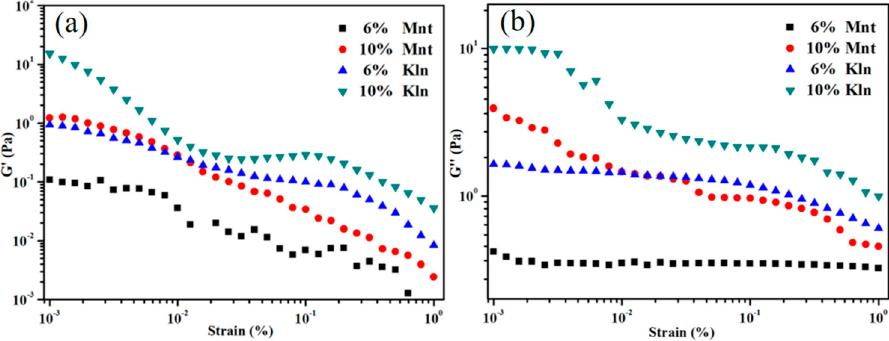
Figure 1. Strain sweep tests on storage ( a ) and loss modulus ( b ) of clay − oil dispersions containing 6% and 10% w / w clay in saturates at 6.28 rad/s frequencies.